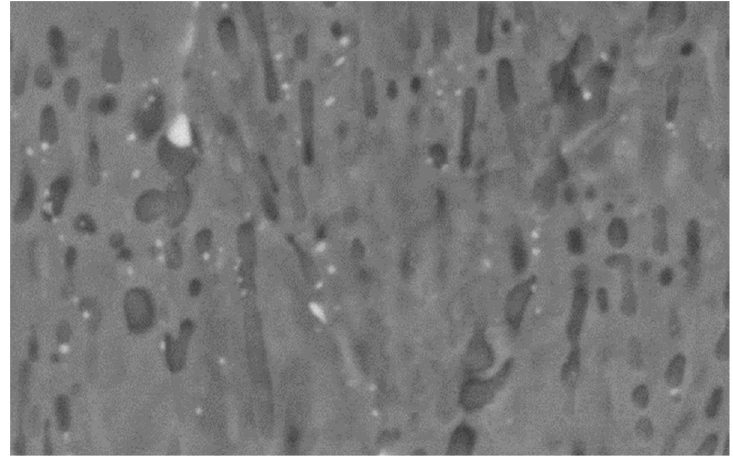
Figure 17. FESEM cross section of the interdiffusion layer (zone 3) of the slurry aluminide coating deposited on HT347HFG steel after 3000 h of exposure to atmospheric steam at 700 °C.